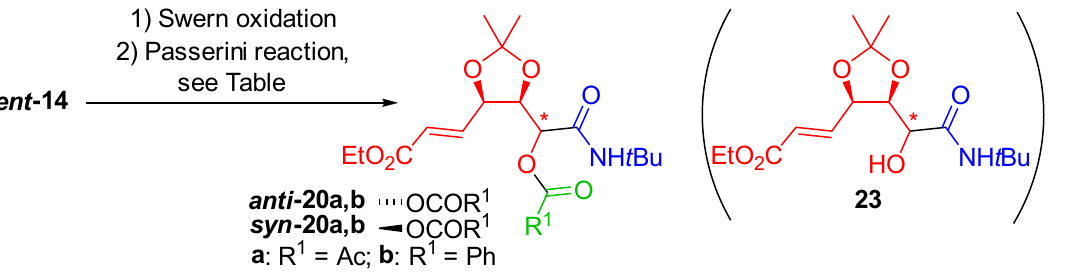
Table 2. Optimization of the stereoselective Passerini